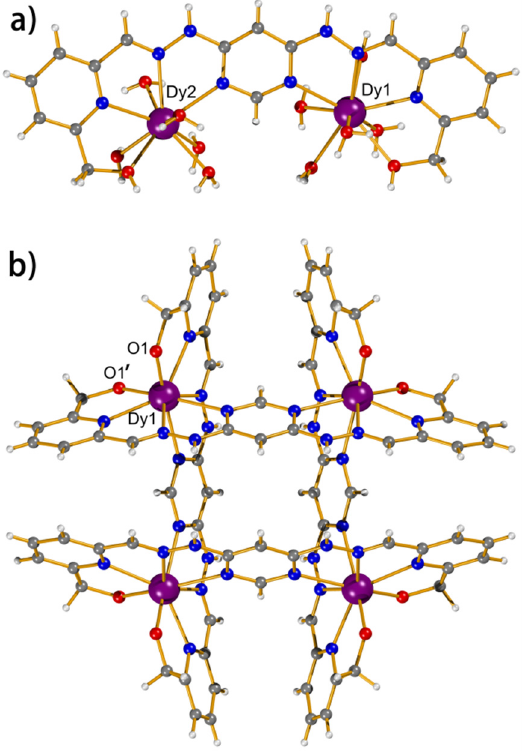
Figure 1. Structures of complexes Dy 2 ( a ) and Dy 4 ( b ). The cations and solvents have been omitted for clarity.